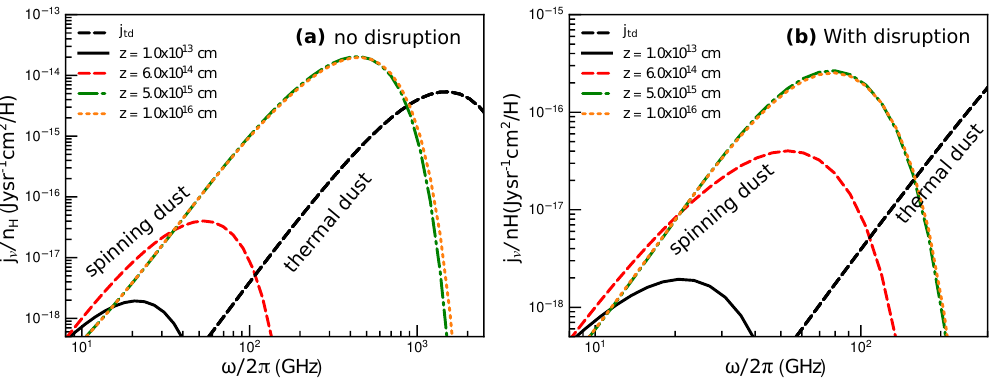
Figure 32. Rotational emission spectrum from spinning nanoparticles for n H = 10 4 cm − 3 and v s = 20kms − 1 computed at several positions in the shock without rotational disruption (panel ( a )) and with rotational disruption for S max = 10 10 ergcm − 3 (panel ( b )). Thermal dust emission from large grains is shown in dashed black line for comparison. From Hoang and Tram [41]. Emissivity is reduced significantly in the presence of